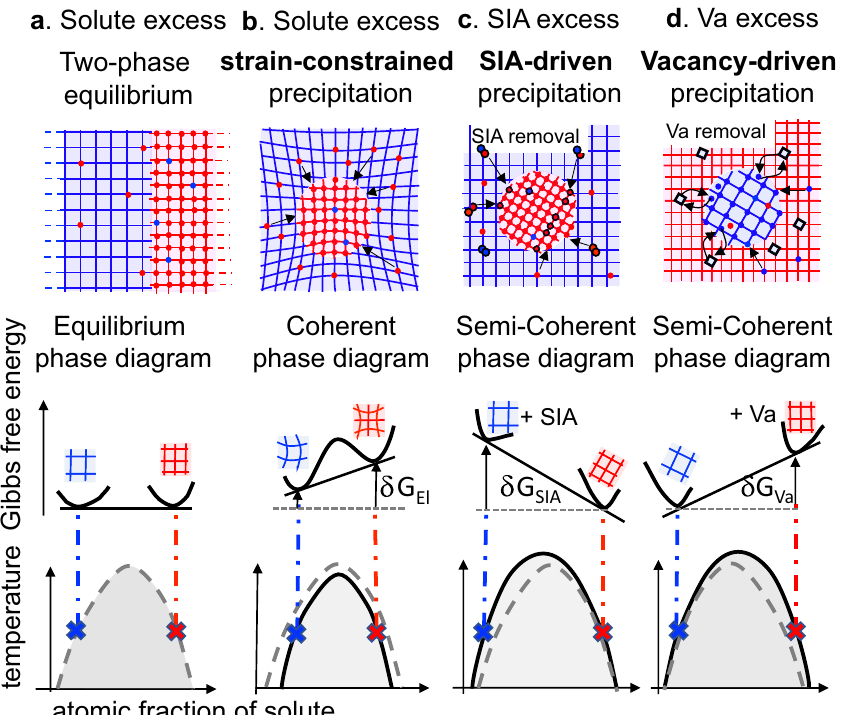
Fig. 1 Concept of semi-coherent phase diagram accounting for the point defect accommodation mechanism. Illustrations of ( a ) the fi nal equilibrium state between in fi nite volume phases (blue and red domains), ( b ) a deformed precipitate (in red) in a supersaturated solution, with an elastic strain ensuring the continuity of the lattice at the precipitate/matrix interface, and reducing the two-phase domain of the phase diagram; ( c , d ) the semi-coherent precipitation in an undersaturated solid solution triggered by respectively an excess of self-interstitial atoms (SIA) and an excess of vacancies (Va). In ( c ), the precipitate eigenstrain is negative (dense precipitate). The transformation of SIAs into substitutional atoms of the precipitate increases the volume of the inclusion resulting from the phase transformation of the parent phase inclusion and decreases the excess Gibbs free energy δ G SIA generated by the excess of SIA. In precipitate, the extra atoms condense into fi nite-size atomic planes leading to mis fi t dislocations. In ( d ), the precipitate eigenstrain is positive (less dense precipitate), the exchange of Va with the atom of the precipitate reduces the volume of the transformed inclusion, and the excess Gibbs free energy δ G Va generated by the excess of Va. The excess of point defects enlarges the two-phase equilibrium domains so that a solid solution initially undersaturated in solute may become unstable with respect to phase